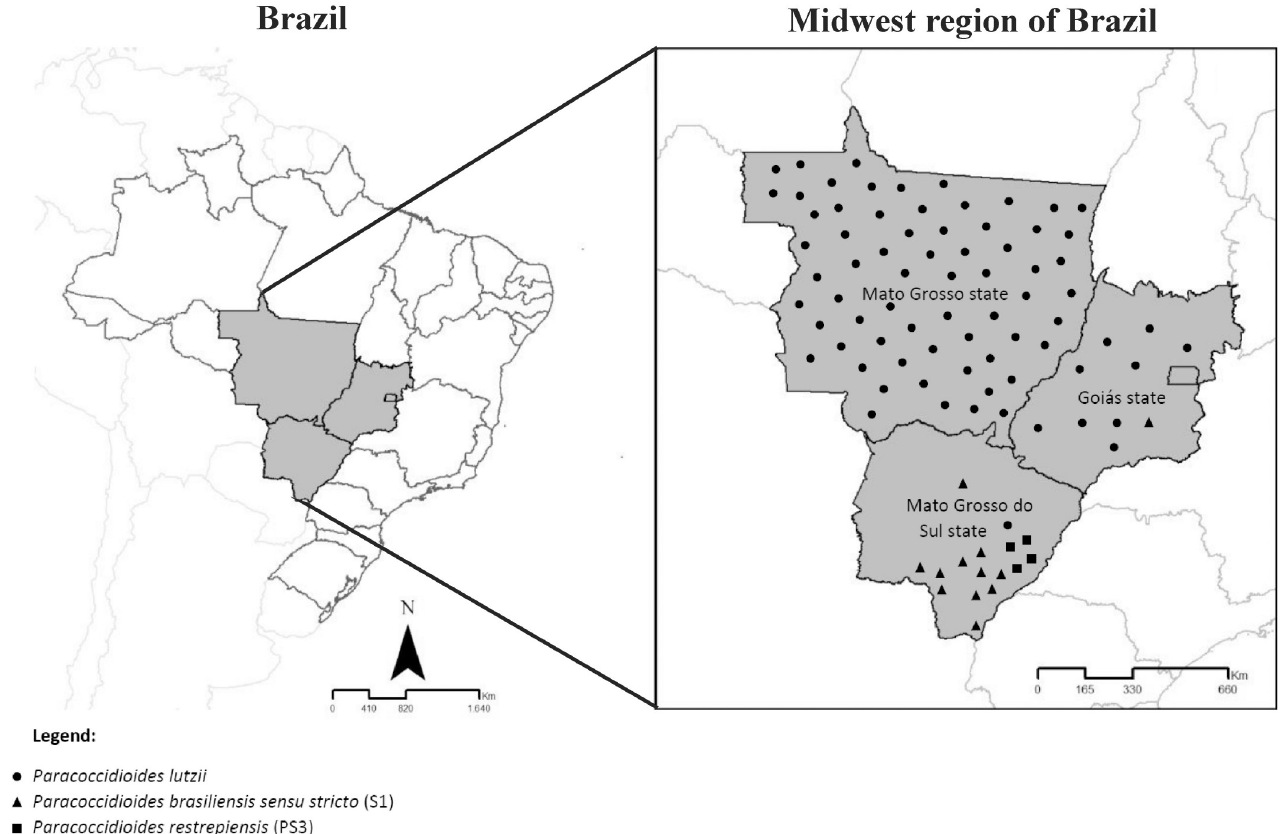
Fig 2. Brazil map showing an update on the Paracoccidioides species distribution in the Midwest region, Brazil. The map groups all Paracoccidioides clinical isolates previously reported in the literature [6,7,9,12,24,25,31,33–35] for this region, additionally with found phylogenetic species from this study. The black triangles ( ▲ ) represent the geographic distribution of P . brasiliensis sensu stricto (S1) in Goia´s and Mato Grosso do Sul (MS) states, black circles ( ● ) indicate the presence of P . lutzii in the three estates, while black squares ( ■ ) are P . restrepiensis (PS3) found only in MS state. The map was treated using the vector graphics editor Corel Draw X8. Source: Cartographic bases (shapefiles) from Brazilian Institute of Geography and Statistics (IBGE) 2013, with maps.